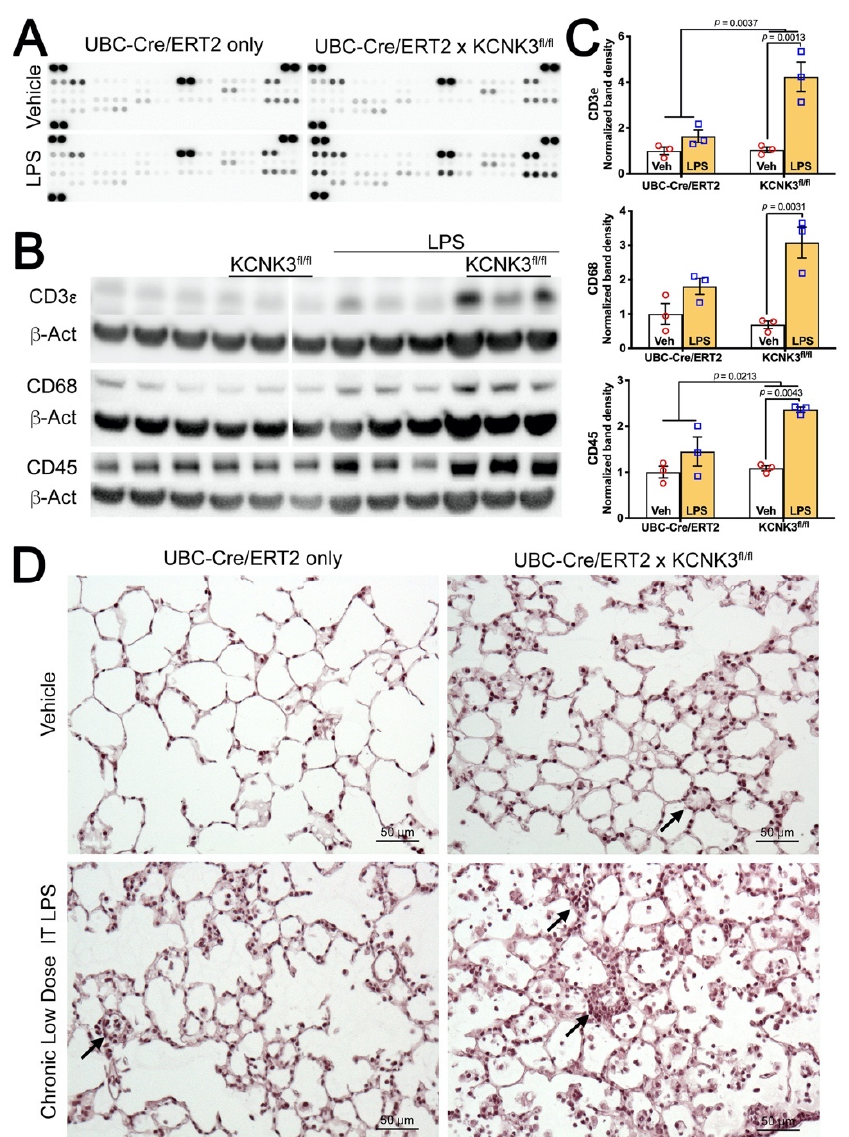
Figure 5. ( A ) Cytokine dot blot arrays indicate stronger response to chronic low dose i.t LPS in UBC-Cre/ERT2 kcnk3 fl/fl homozygous mice than in UBC-Cre/ERT2 only controls. (Quantified in Table 3). Image has had Gamma set to 0.1 to make lower intensity dots more visible. ( B ) Western blot on whole lung shows higher levels of CD3 ε + cells (T cells), CD68 + cells (macrophages), and CD45 + cells (all hematopoietic cells) in UBC-Cre/ERT2 kcnk3 fl/fl mice compared to UBC-Cre/ERT2 only controls with LPS. ( C ) Quantification of Western blots; probabilities are by two-way ANOVA with post-hoc pairwise comparisons. ( D ) H&E-stained lungs allowing visualization of increased cellularity in kcnk3 fl/fl mice compared to UBC-Cre/ERT2 only controls with LPS. Black arrows represent the pulmonary